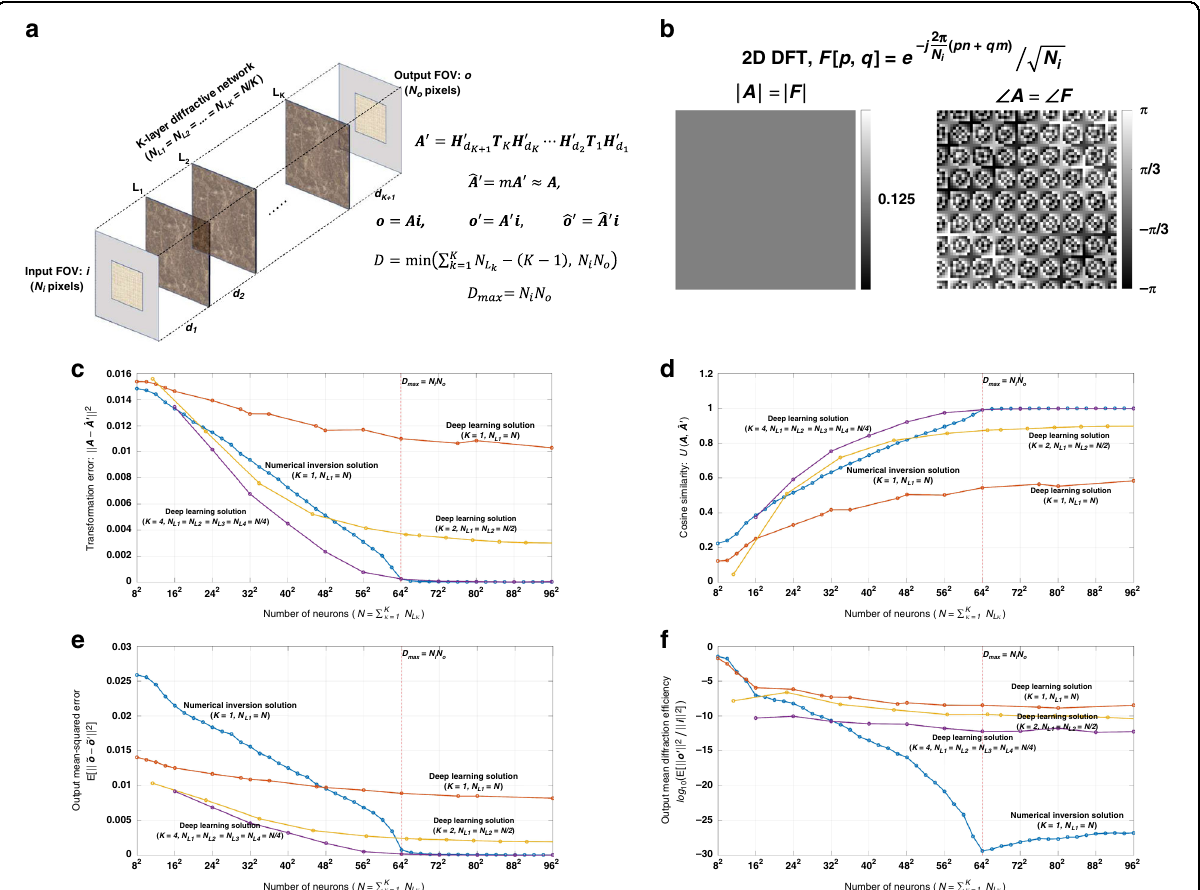
Fig. 7 Diffractive all-optical transformation results for the 2D discrete Fourier transform. a Schematic of a K-layer diffractive network, that all- optically performs a linear transformation between the input and output fi elds-of-views that have N i and N o pixels, respectively. The all-optical transformation matrix due to the diffractive layer(s) is given by A ′ . b . The magnitude and phase of the ground truth (target) input-output transformation matrix, which is the 2D Fourier transform matrix. c All-optical transformation errors (see Eq. 5). The x -axis of the fi gure shows the total number of neurons ( N ) in a K-layered diffractive network, where each diffractive layer includes N / K neurons. Therefore, for each point on the x-axis, the comparison among different diffractive designs (colored curves) is fair as each diffractive design has the same total number of neurons available. The simulation data points are shown with dots and the space between the dots are linearly interpolated. d Cosine similarity between the vectorized form of the target transformation matrix in ( b ) and the resulting all-optical transforms (see Eq. 16). e Output MSE between the ground- truth output fi elds and the estimated output fi elds by the diffractive network (see Eq. 18). f The diffraction ef fi ciency of the designed diffractive networks (see Eq.